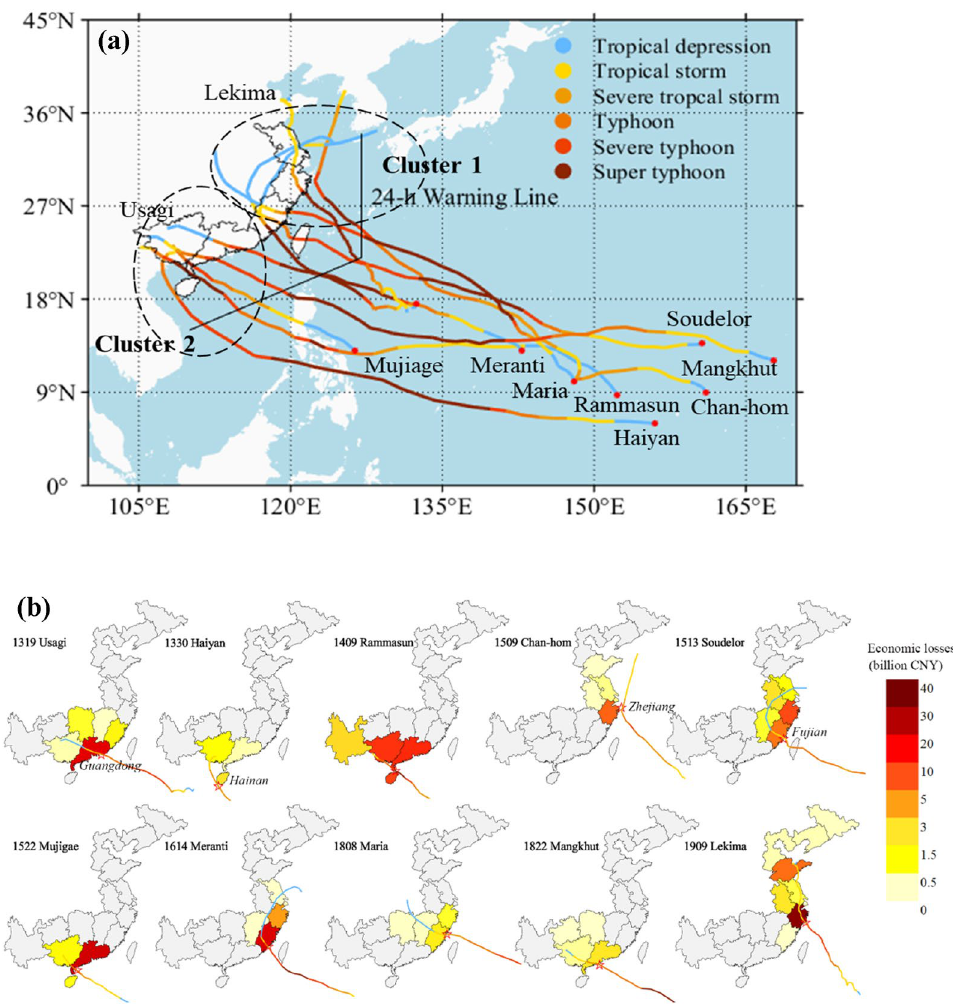
Figure 1. Ten historical super typhoons and damage in coastal area of China. ( a ) Tracks of the 10 landing SuperTYs. ( b ) Direct economic loss (consumer price index CPI-2013 adjusted losses) distribution. Shadings indicate the damage level of TC-affected provinces. Lines indicate the tracks of the selected typhoons. Historical damage data are mainly from China Meteorological Yearbook . The four directly hit provinces, i.e., Guangdong, Hainan, Zhejiang and Fujian, are labeled. Maps were generated by MATLAB R2021a (http:// www. mathw orks.